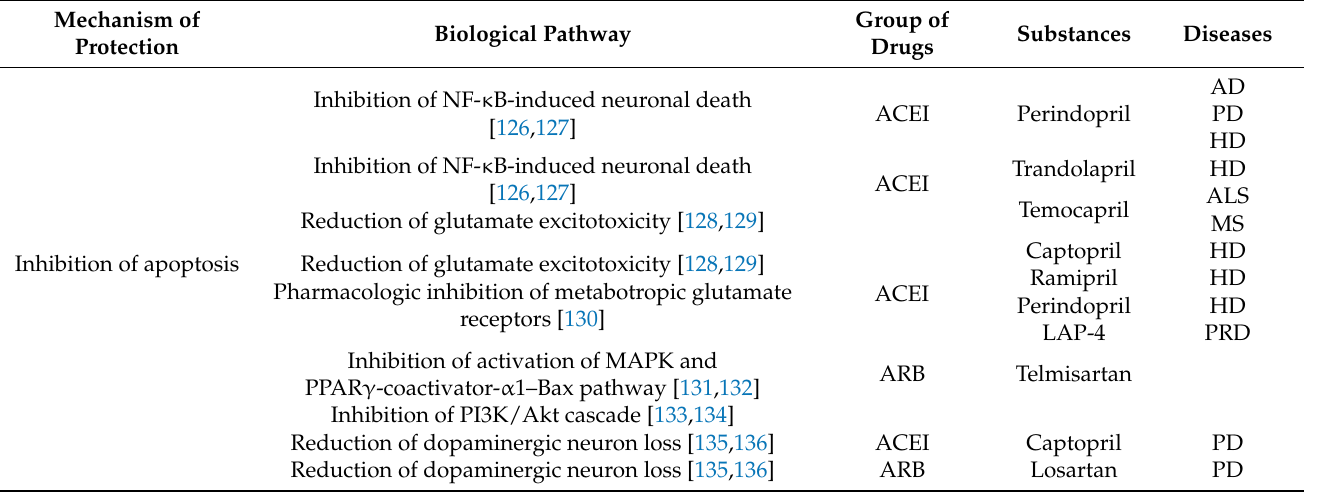
Table 5. Protective mechanisms of RAS pharmacological modulators via the inhibition of neu- ronal